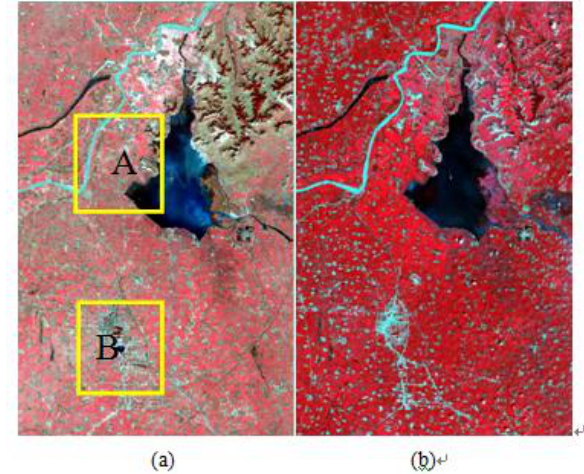
Fig.2. Landsat Images of the study area. (a) predicted image on